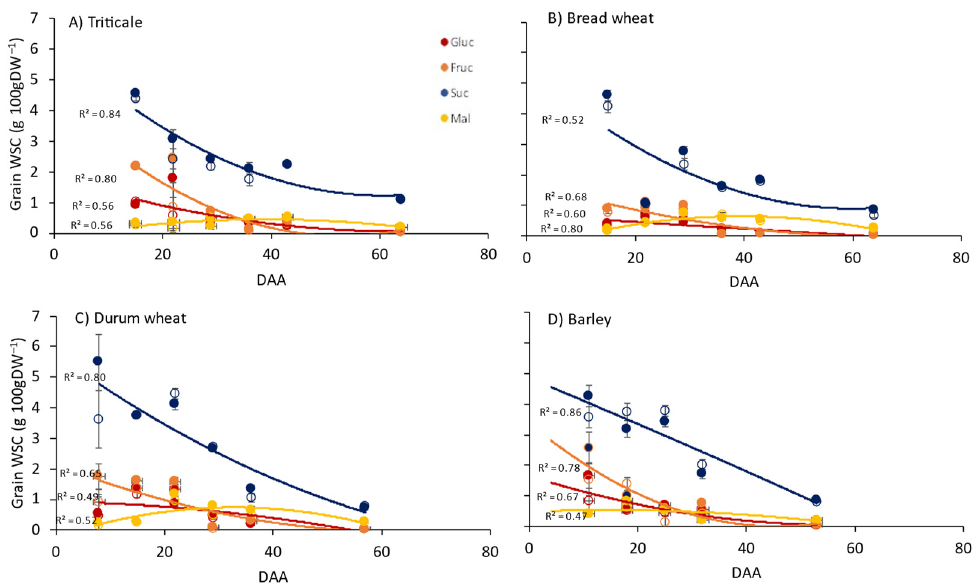
Figure 3. Time variation (expressed as days after anthesis, DAA) of the concentrations of different water-soluble carbohy- drates (WSCs) (glucose, fructose, sucrose and maltose) (g 100 g DW − 1 ) in grain in ( A ) triticale, ( B ) bread wheat, ( C ) durum wheat, and ( D ) barley under water-limited (open symbols) and well- watered (close symbols) regimes. The regression equations are in Table S3.